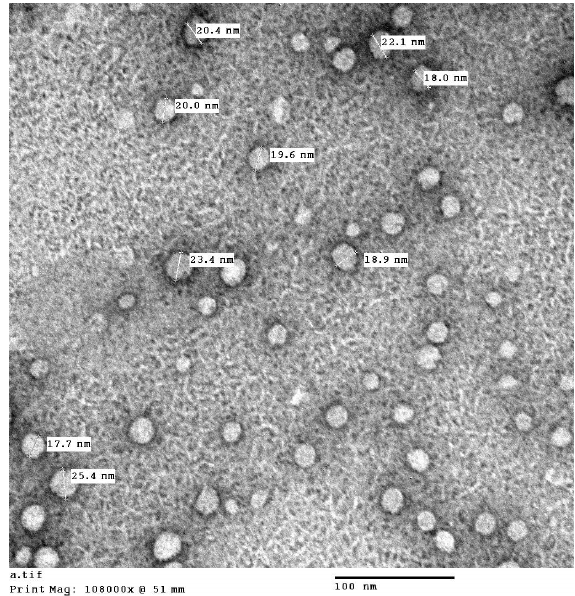
Figure 1. TEM image of 2ME TPGS micelles.